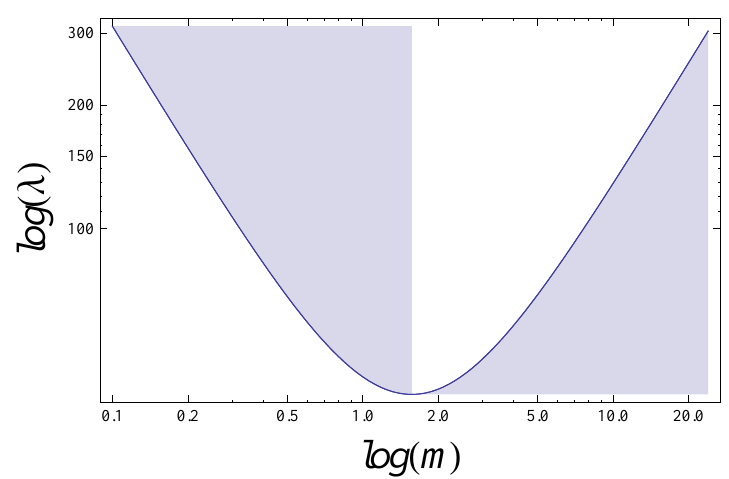
Figure 2. The physical nature of the radius λ (cid:48) changes dramatically at the minimum close to m = m P . C / S Particles are defined by the existence of a minimum radius; attempts to compress the width of the wave packet beyond this result in pair-production, rather than further spatial localization. Black holes are defined by the existence of a maximum radius; within this, the wave packet associated with the central black hole mass is “contained”, indicating the causal disconnect between the black hole’s interior and its exterior surroundings [1]. (Nonetheless, in principle, this picture remains consistent with the existence of Hawking radiation, which may be interpreted as the result of QM tunneling through an effective potential boundary, located in the region of the classical black hole